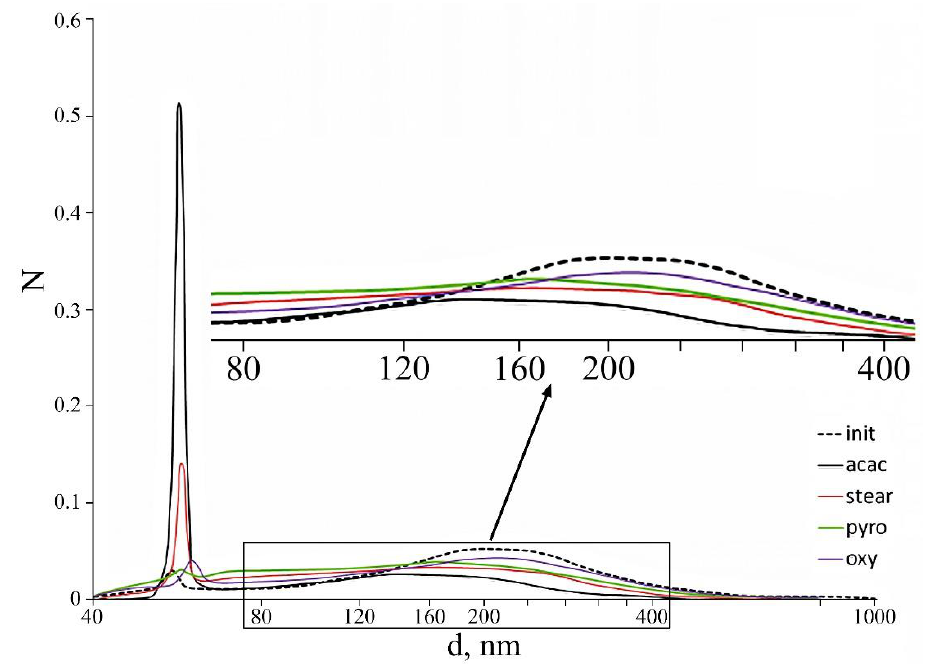
Figure 9. Size distribution of nanoparticle agglomerates.